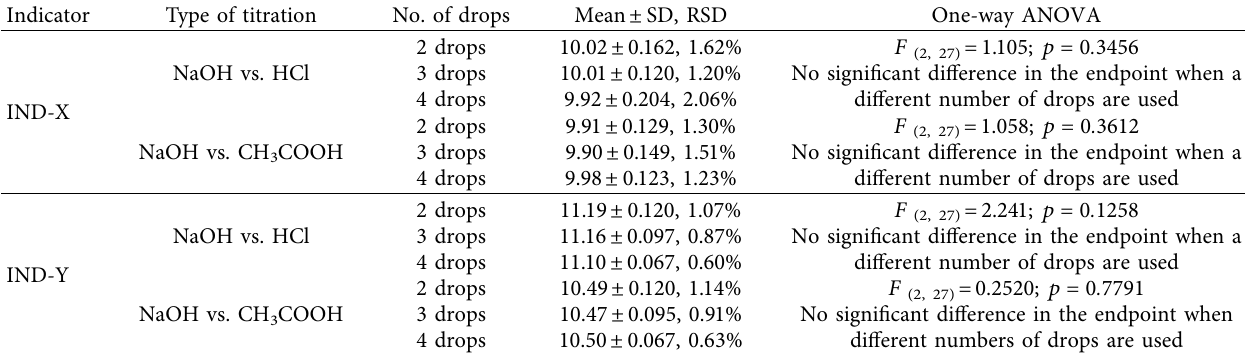
Table 4: Results showing precision of outcomes from the use of the proposed indicators. Indicator Type of